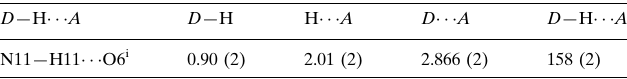
Hydrogen-bond geometry (A˚ , (cid:2)